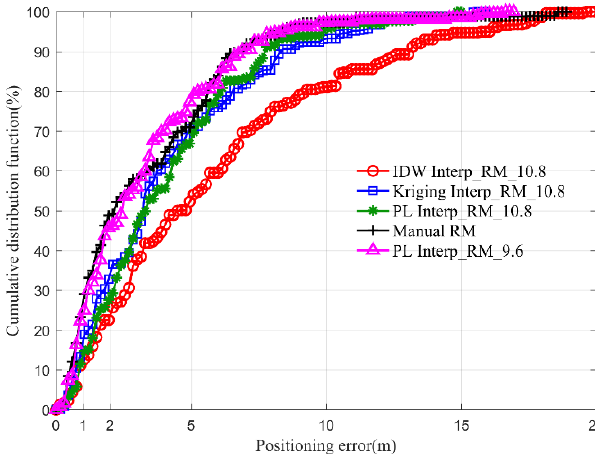
Figure 9. Cumulative distribution of localization errors of different interpolated radio maps generated by sparse RPs with different intervals and manual radio map.